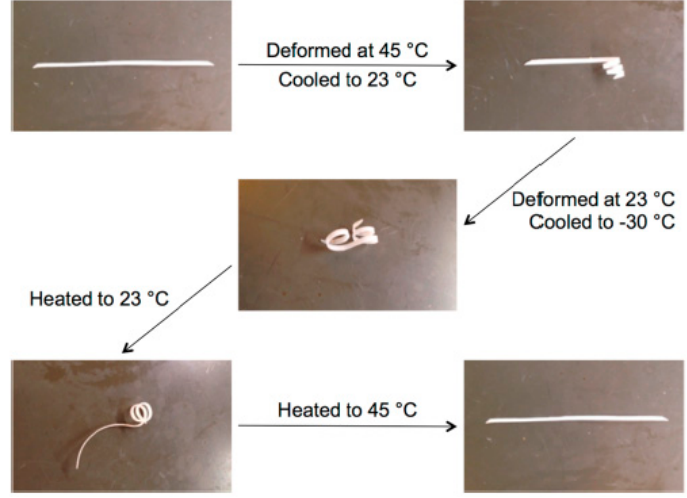
Figure 1. Triple shape memory effect of a dual-curing material based on selective thiol–Michael addition to divinyl sulfones and acrylates with two well-separated glass transitions. Adapted with permission from [64]. Copyright: 2014, American Chemical Society.